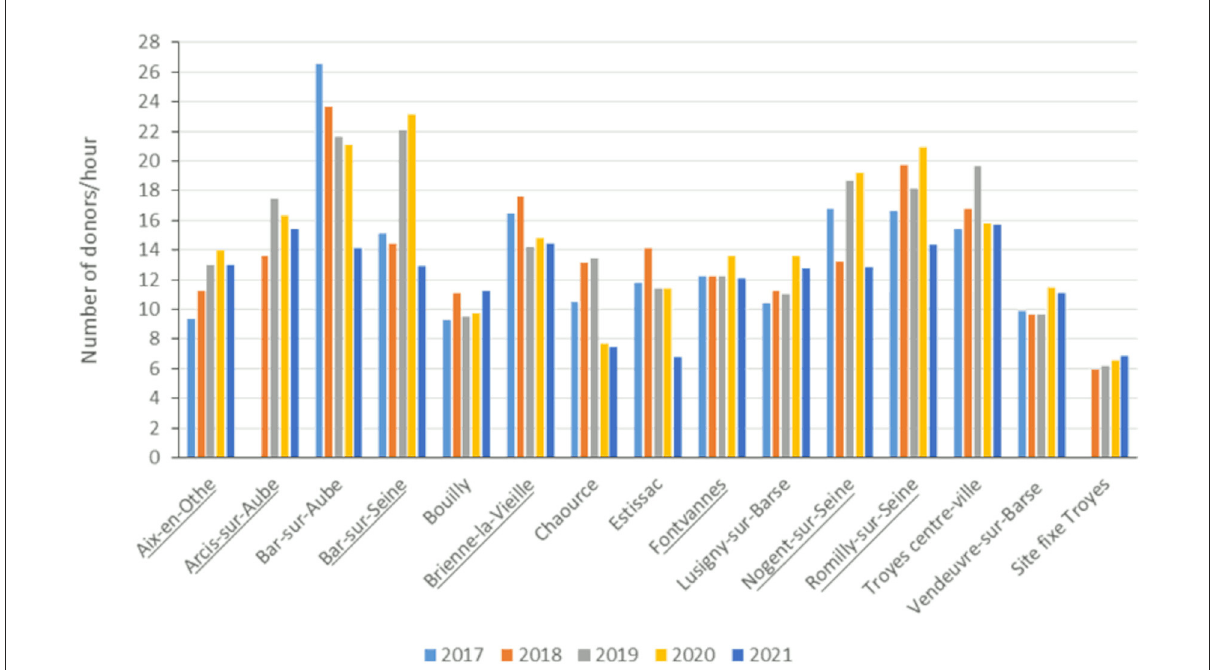
FIGURE2 Trends in attendance at blood drives between 2017 and 2021, stratified by donation site. Data provided by the French Blood Transfusion Service (BTS). Underlined towns are the locations of the blood drives included in the